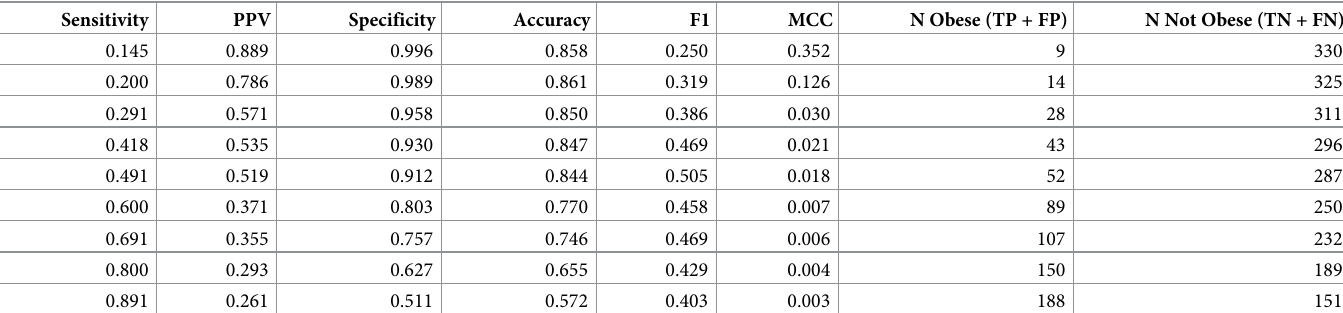
Table 6. Performance tradeoffs for the best performing model for girls. Sensitivity